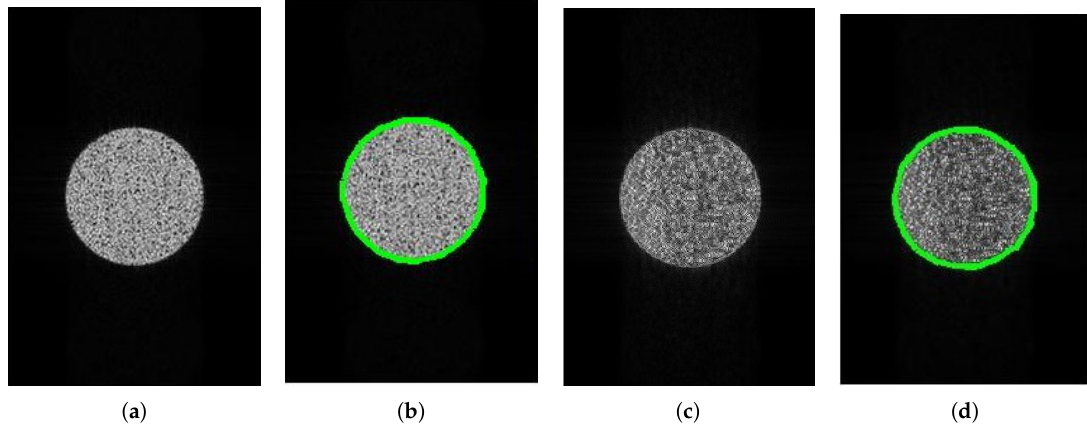
Figure 6. The imaging and edge detection result for the circular area. ( a ) Original image; ( b ) edge detection result of the original image; ( c ) edge-enhanced SAR image; ( d ) edge detection result of the edge-enhanced SAR image.